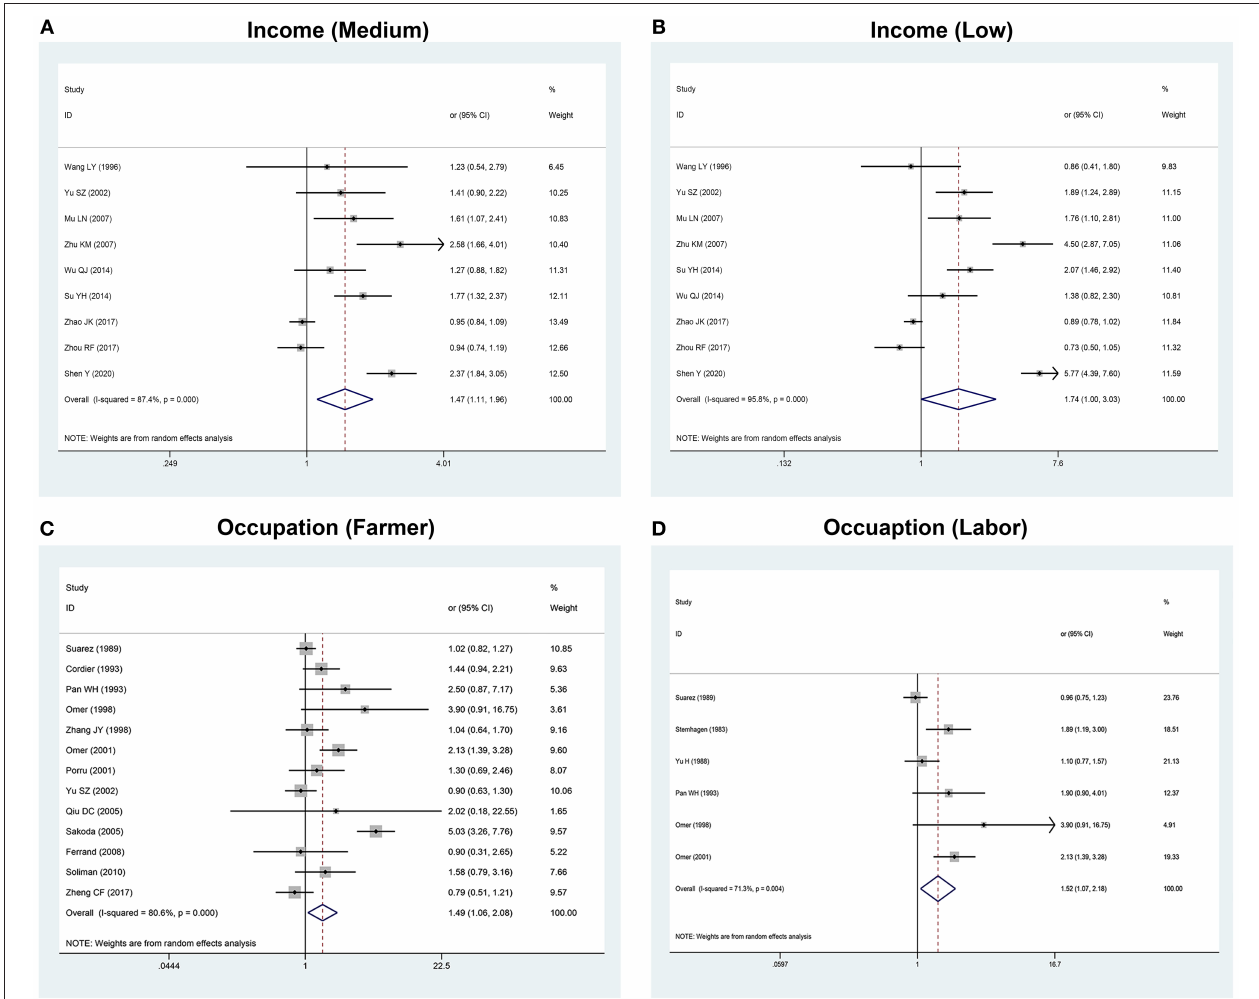
FIGURE 3 | The forest plots of the association between the risk factors and HCC. (A) Association between income (medium) and HCC. (B) Association between income (low) and HCC. (C) Association between occupation (farmer) and HCC. (D) Association between occupation (labor) and HCC.